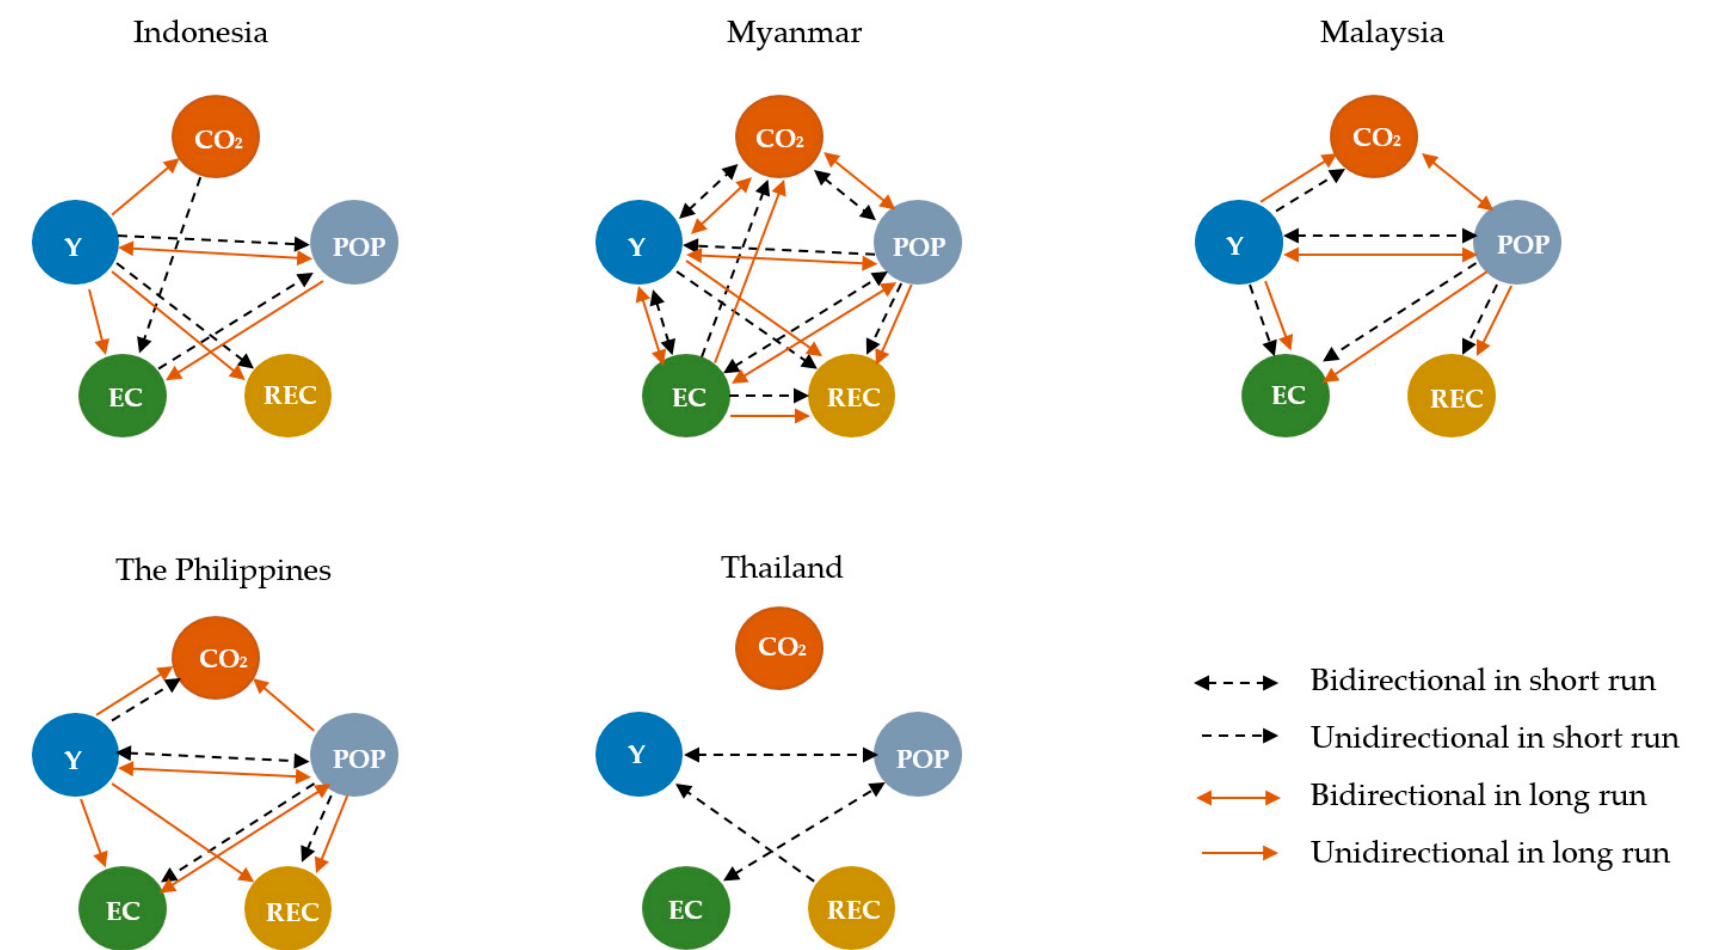
Figure 1. Summary of Granger causality tests. CO 2 —per capita CO 2 emissions; EC—per capita energy consumption; Y: real per capita GDP and its square form; POP—population growth rate; REC—per capita consumption of renewable energy.